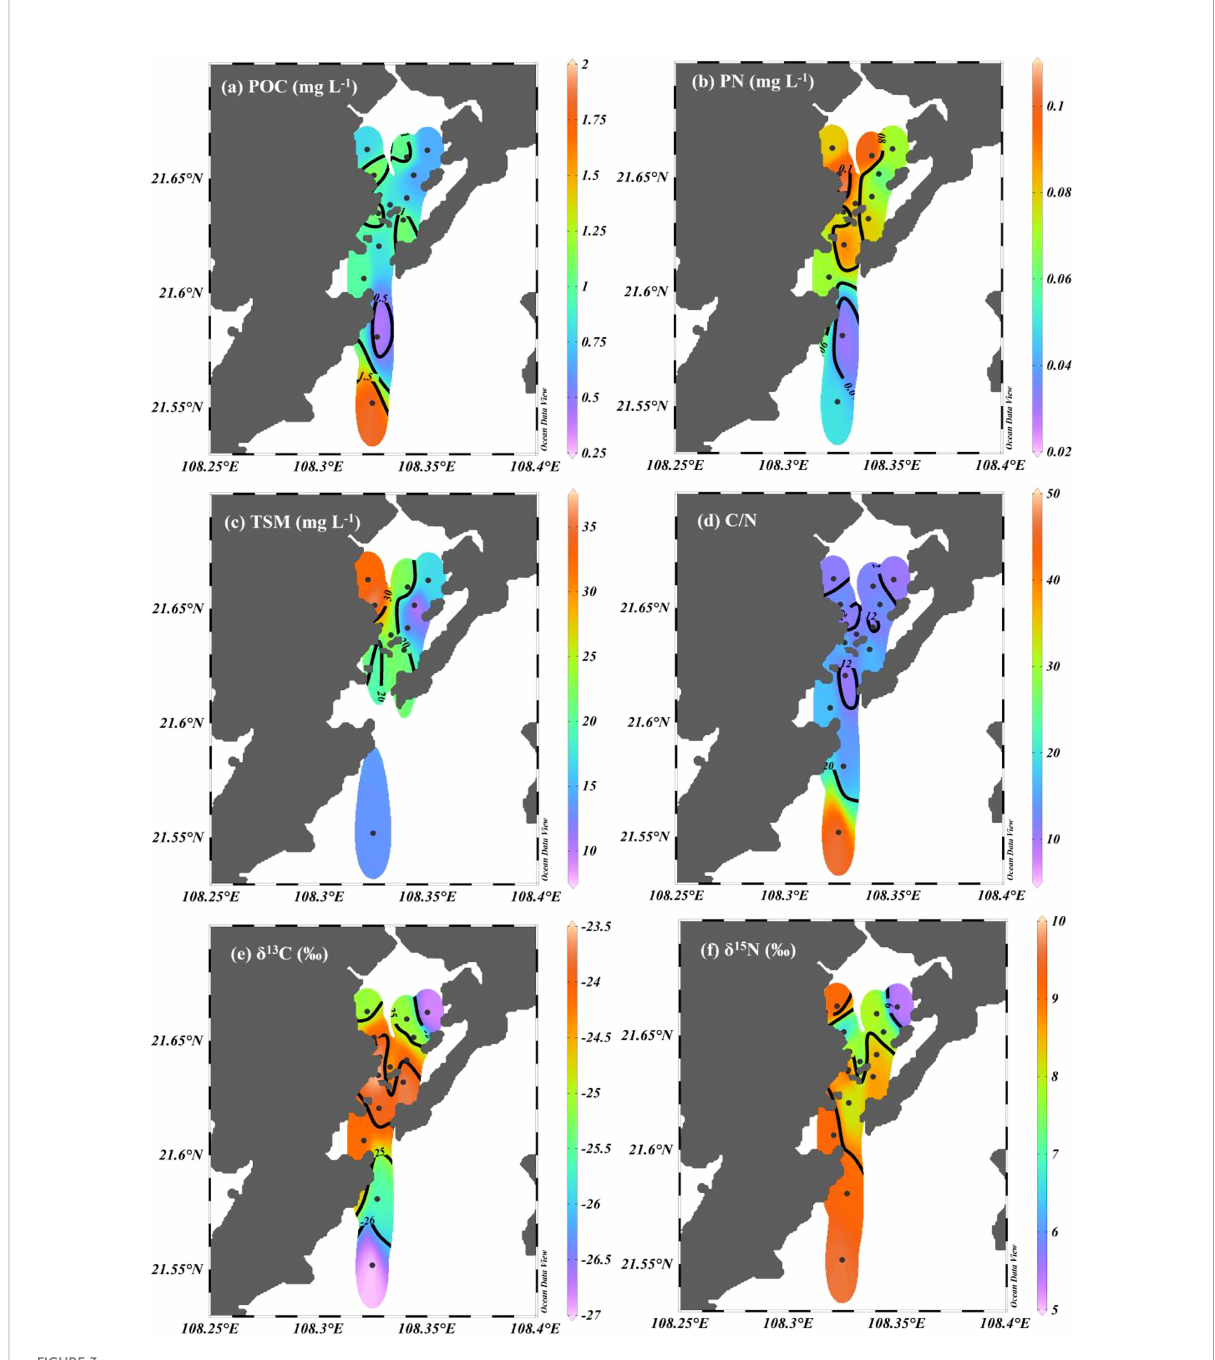
FIGURE 3 Spatial distributions of (A) POC, (B) PN, (C) TSM, (D) C/N, (E) d 13 C, and (F) d 15 N in Xi Bay. Black dots represent the sampling